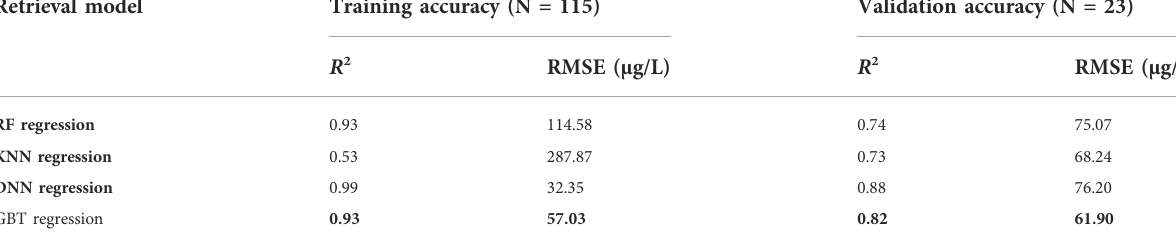
TABLE 3 Accuracy evaluation of PC concentration retrieval models for MODIS